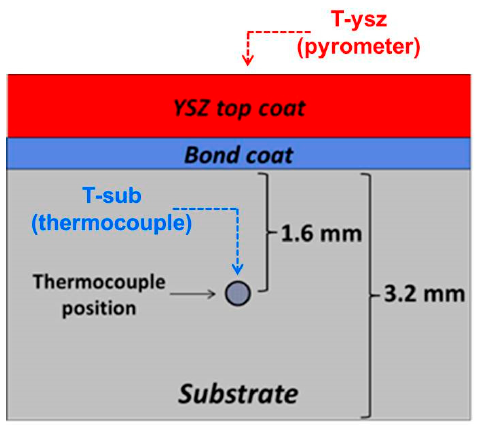
Figure 6. Schematic of TBC/substrate architecture displaying T-ysz and T-sub measurement locations.